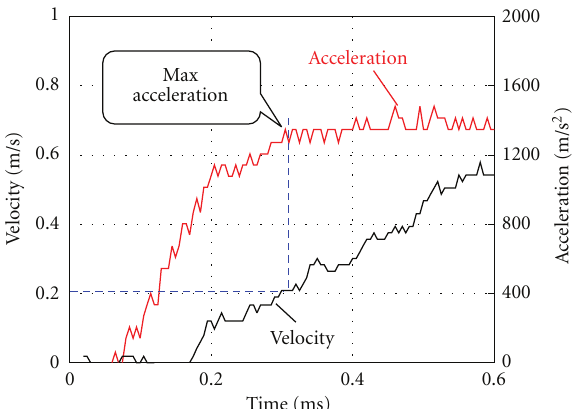
Figure 7: Radial velocity and acceleration of the head in full stroke seek operation.